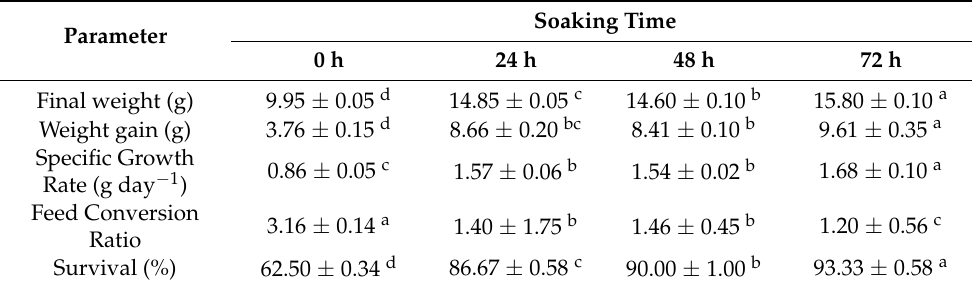
Table 3. Zootechnical parameters of Clarias gariepinus fed soaked Jatropha curcas kernel-based diets. Numbers are means ± standard errors.